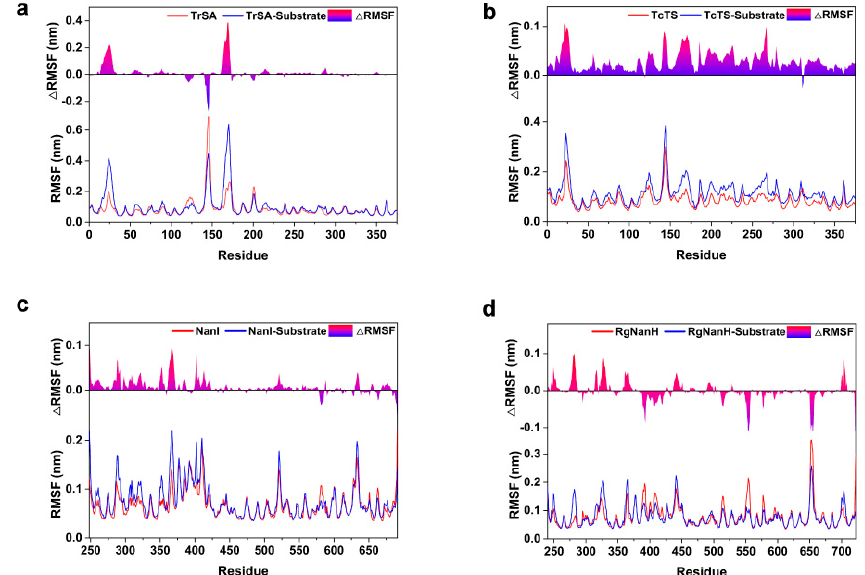
Figure 2. Structural flexibility of GH33 sialidases with and without the substrates. The RMSF values of the substrate-free and substrate-bound states are shown in red and blue lines, respectively. The changes in the RMSF are shown with filling bars. Structural flexibility of TrSA, TcTS, NanI and RgNanH with and without the substrates are shown in ( a – d ), respectively.